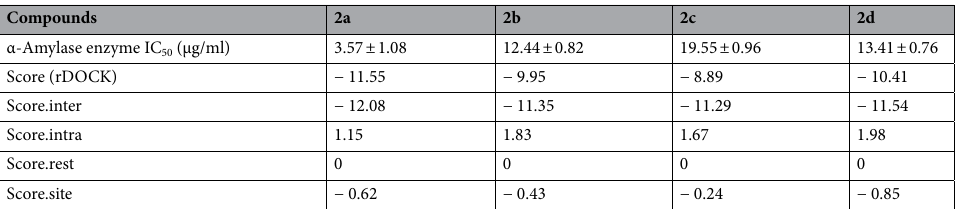
Table 3. The molecular Docking score of the 2-(phenylthio)-ethyl benzoate derivatives inside α-amylase crystal structure (PDB code: 4w93) within 6 Å around the binding pocket. The rDock master scoring function (Score) is a sum of intermolecular (Score.inter), ligand intramolecular (Score.intra), site intramolecular (Score. site), and external restraint terms (Score.restraint). [rDOCK manual: see http:// rdock. sourc eforge. net/ docum entat